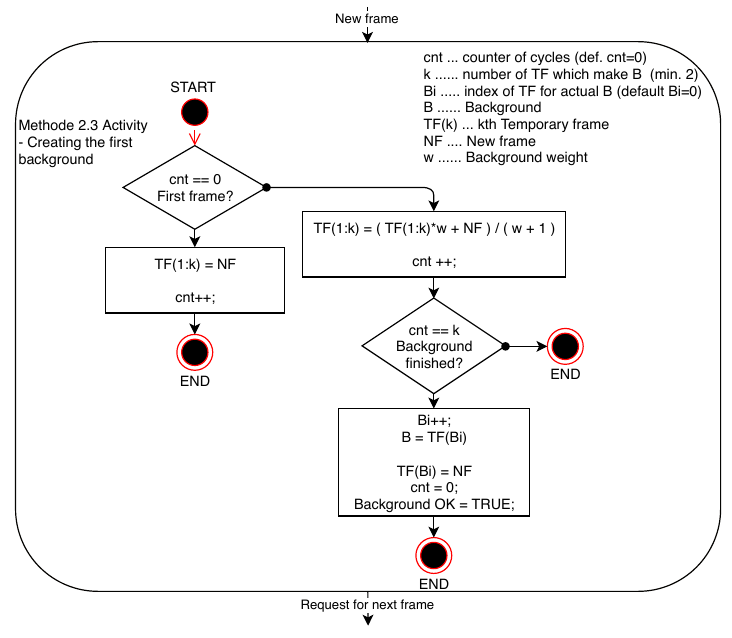
Figure 14. Diagram of Method 2.3 activity—creation of the initial